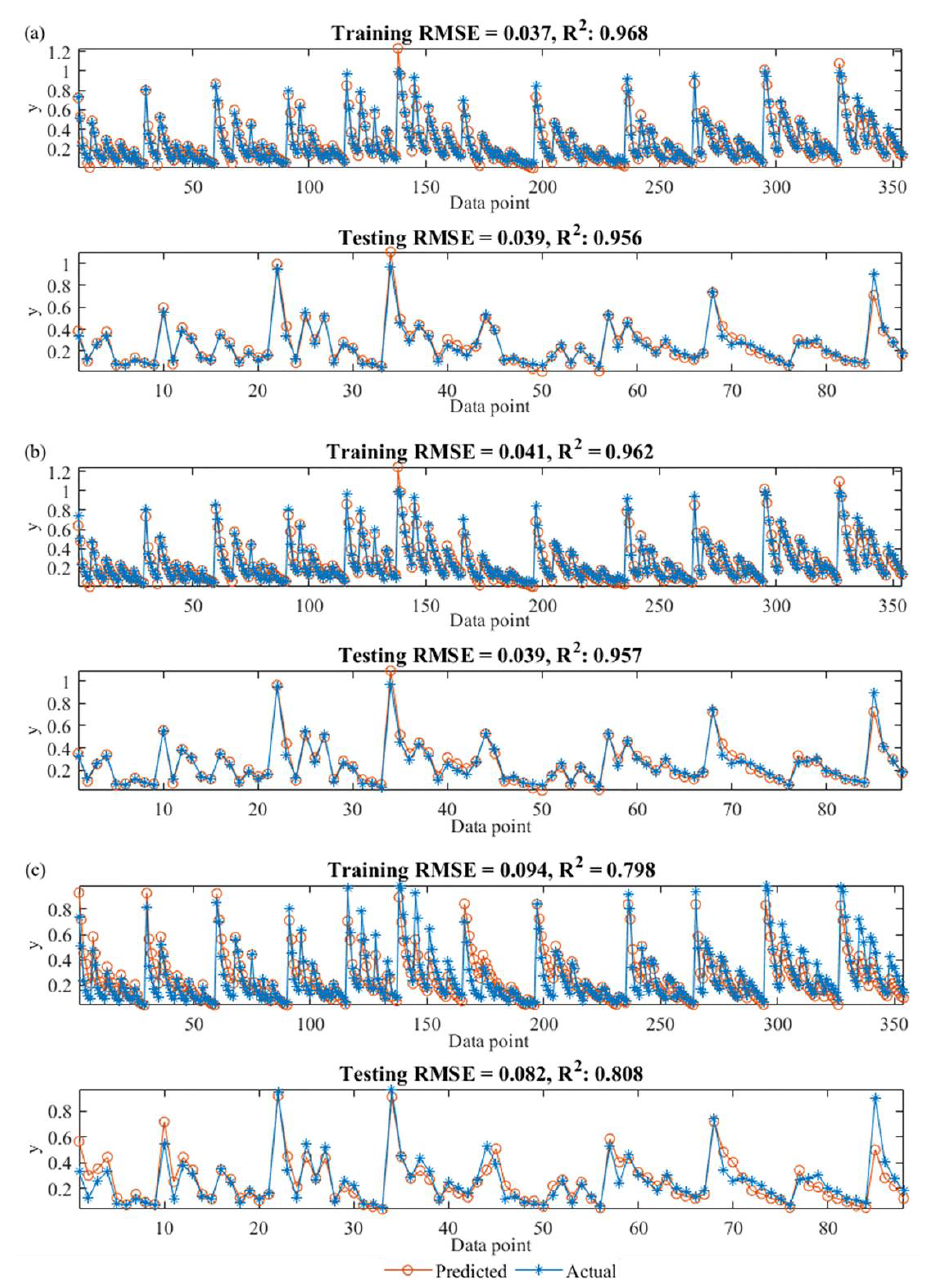
Figure 5. Comparison of actual and MGGP results: ( a ) Model A; ( b ) Model B; and ( c ) Model C.